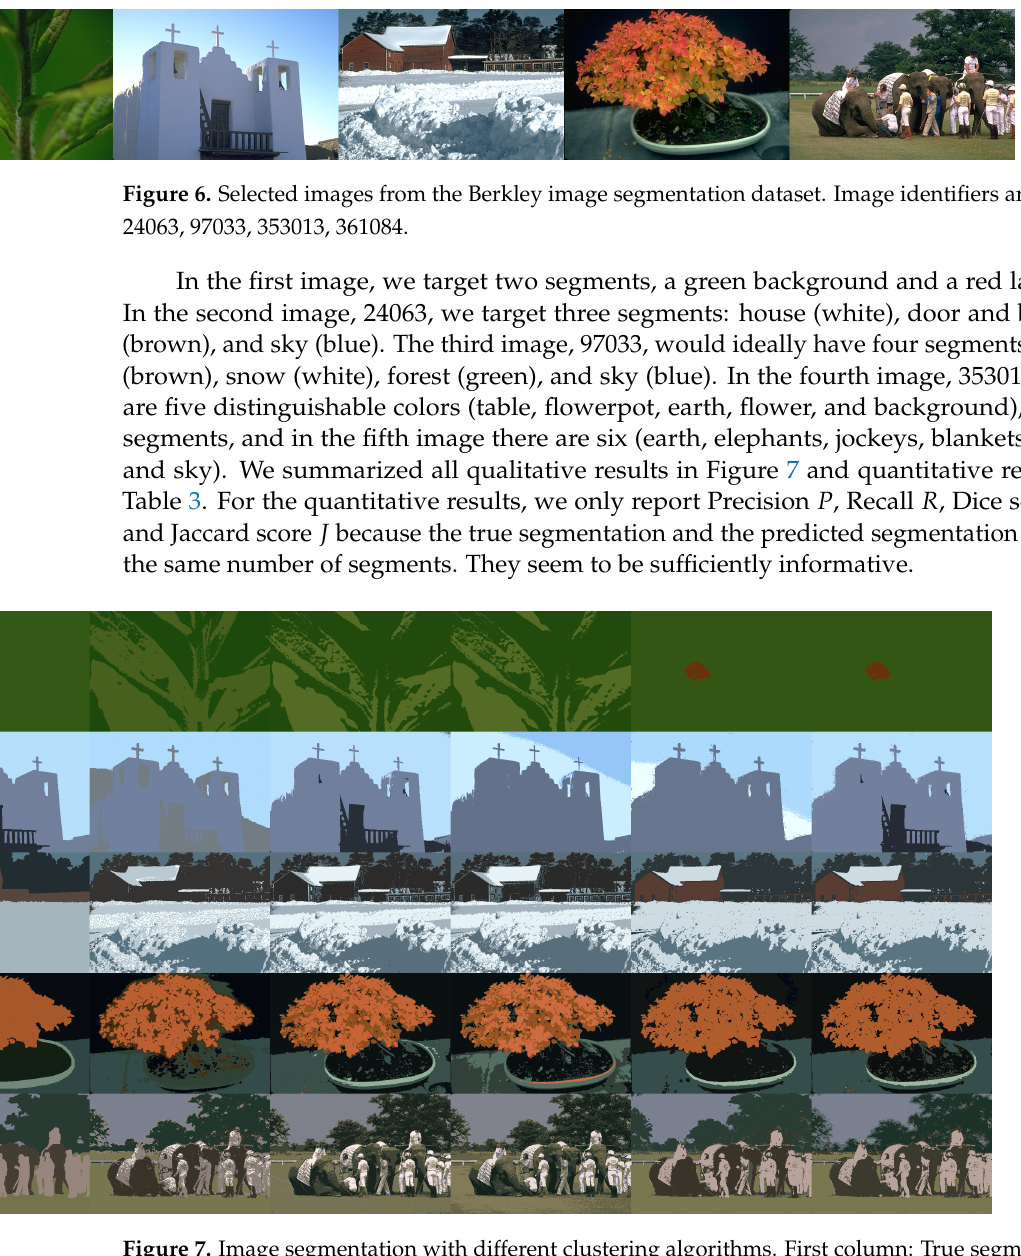
Figure 7. Image segmentation with different clustering algorithms. First column: True segmentation; Second column: GMM; Third column: KMEANS; Fourth column: FCMEANS; Fifth column: ENT; Sixth column: